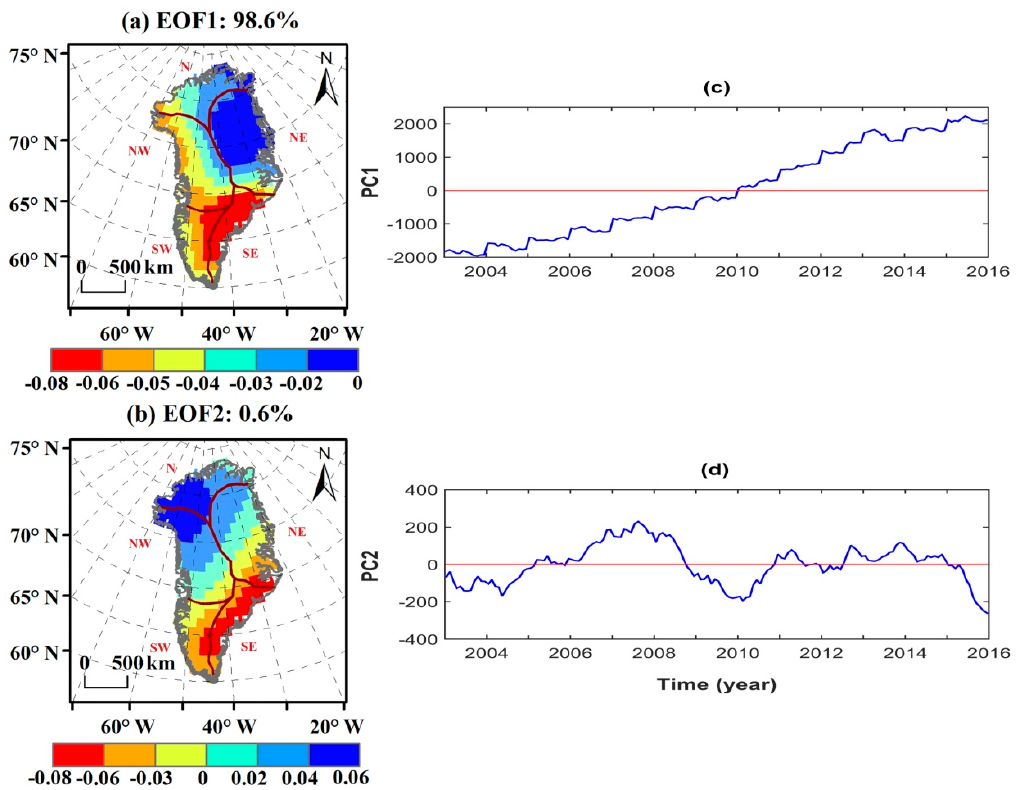
Figure 5. Spatial distribution ( a , b ) and time coefficient ( c , d ) change of the first and second EOF modes. Note: The time coefficients and EOF variables in the figure indicate relative size and are dimensionless.